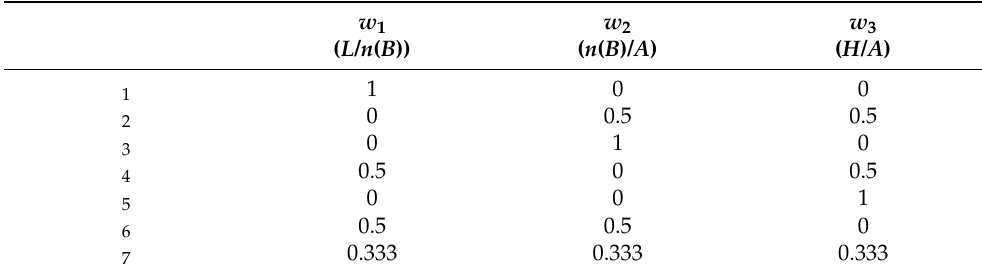
Table 3. Matrix of the relation between the scenario S and the weight coefficients w .